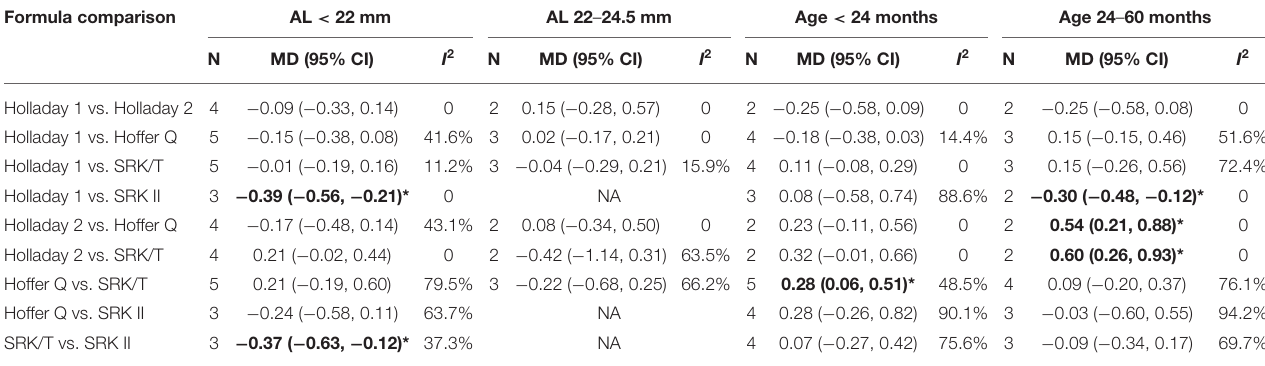
TABLE 4 | Mean difference of absolute prediction error (APE) between groups stratified by age and axial length. Formula